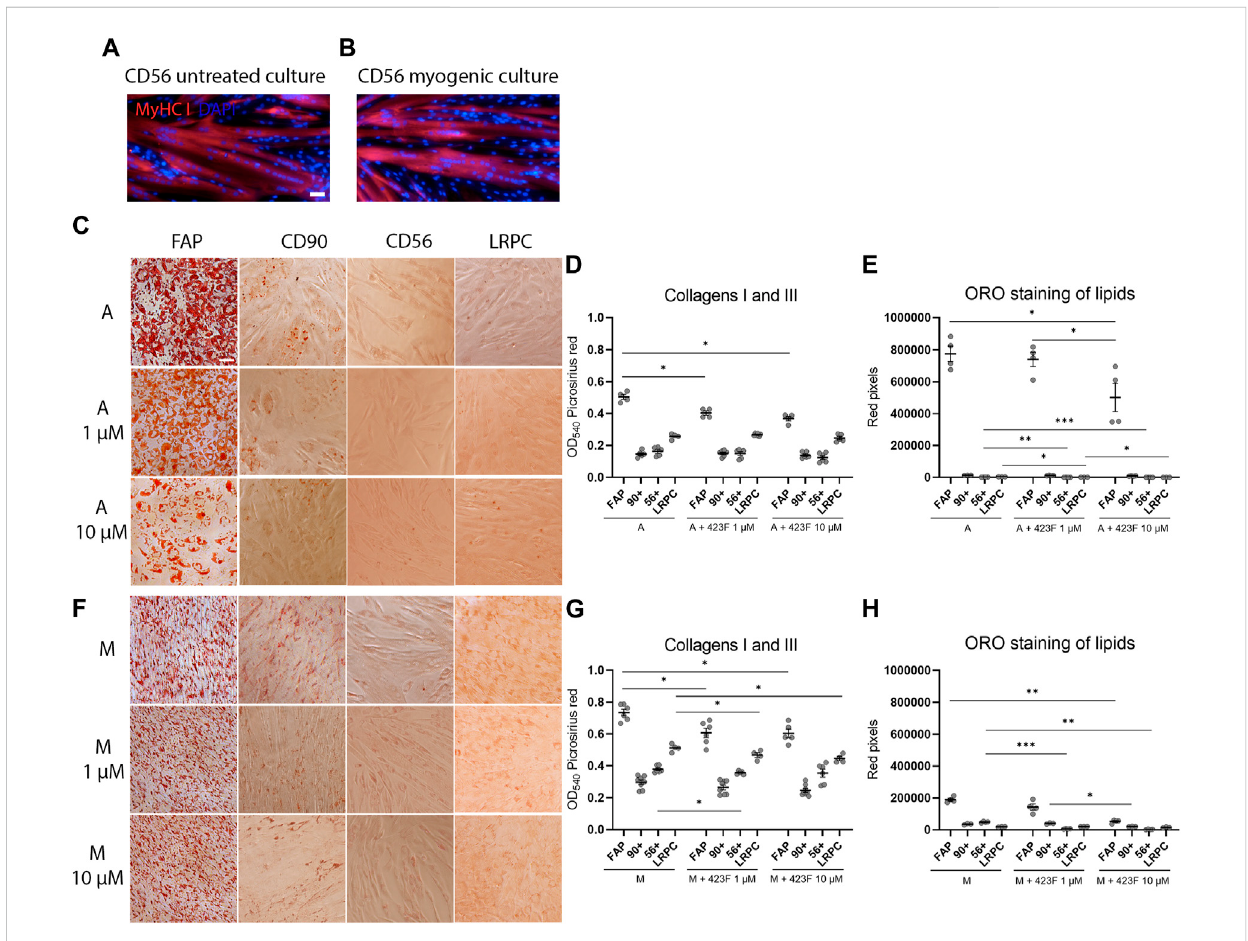
FIGURE 4 423F elicits greater inhibition of human muscle FAP fi bro-adipogenic differentiation than that of CD56, CD90, and LRPC in adipogenic and myogenic cultures. (A – B) Myogenic differentiation is detected only in CD56 subset as seen in representative images of DAPI and Myosin heavy Chain I (MyHCI)-stainedsyncytialcellsfromCD56inuntreatedculture (A) andmyogenicserum-inducedculture (B) .RepresentativeimagesofOilRedO-stained adipogenic cells in adipogenic (C) and myogenic cultures (F) for each cell subset. Picrosirius red spectrophotometric quanti fi cation of collagen production (D, G) and red pixel quanti fi cation of Oil red O-stained adipocytes (E, H) at the indicated conditions in the presence or absence of 1 uM and 10 µM423F.Data(mean±SEM)waspooledfrommultipleexperimentswithtriplicatesforallcultures(n=atleast3percellsubset).Datawasanalyzedvia paired one-way ANOVA and Tukey ’ s post hoc multiple comparisons. *** p < 0.001, ** p < 0.01, * p < 0.05. Scale bar represents 100 μ